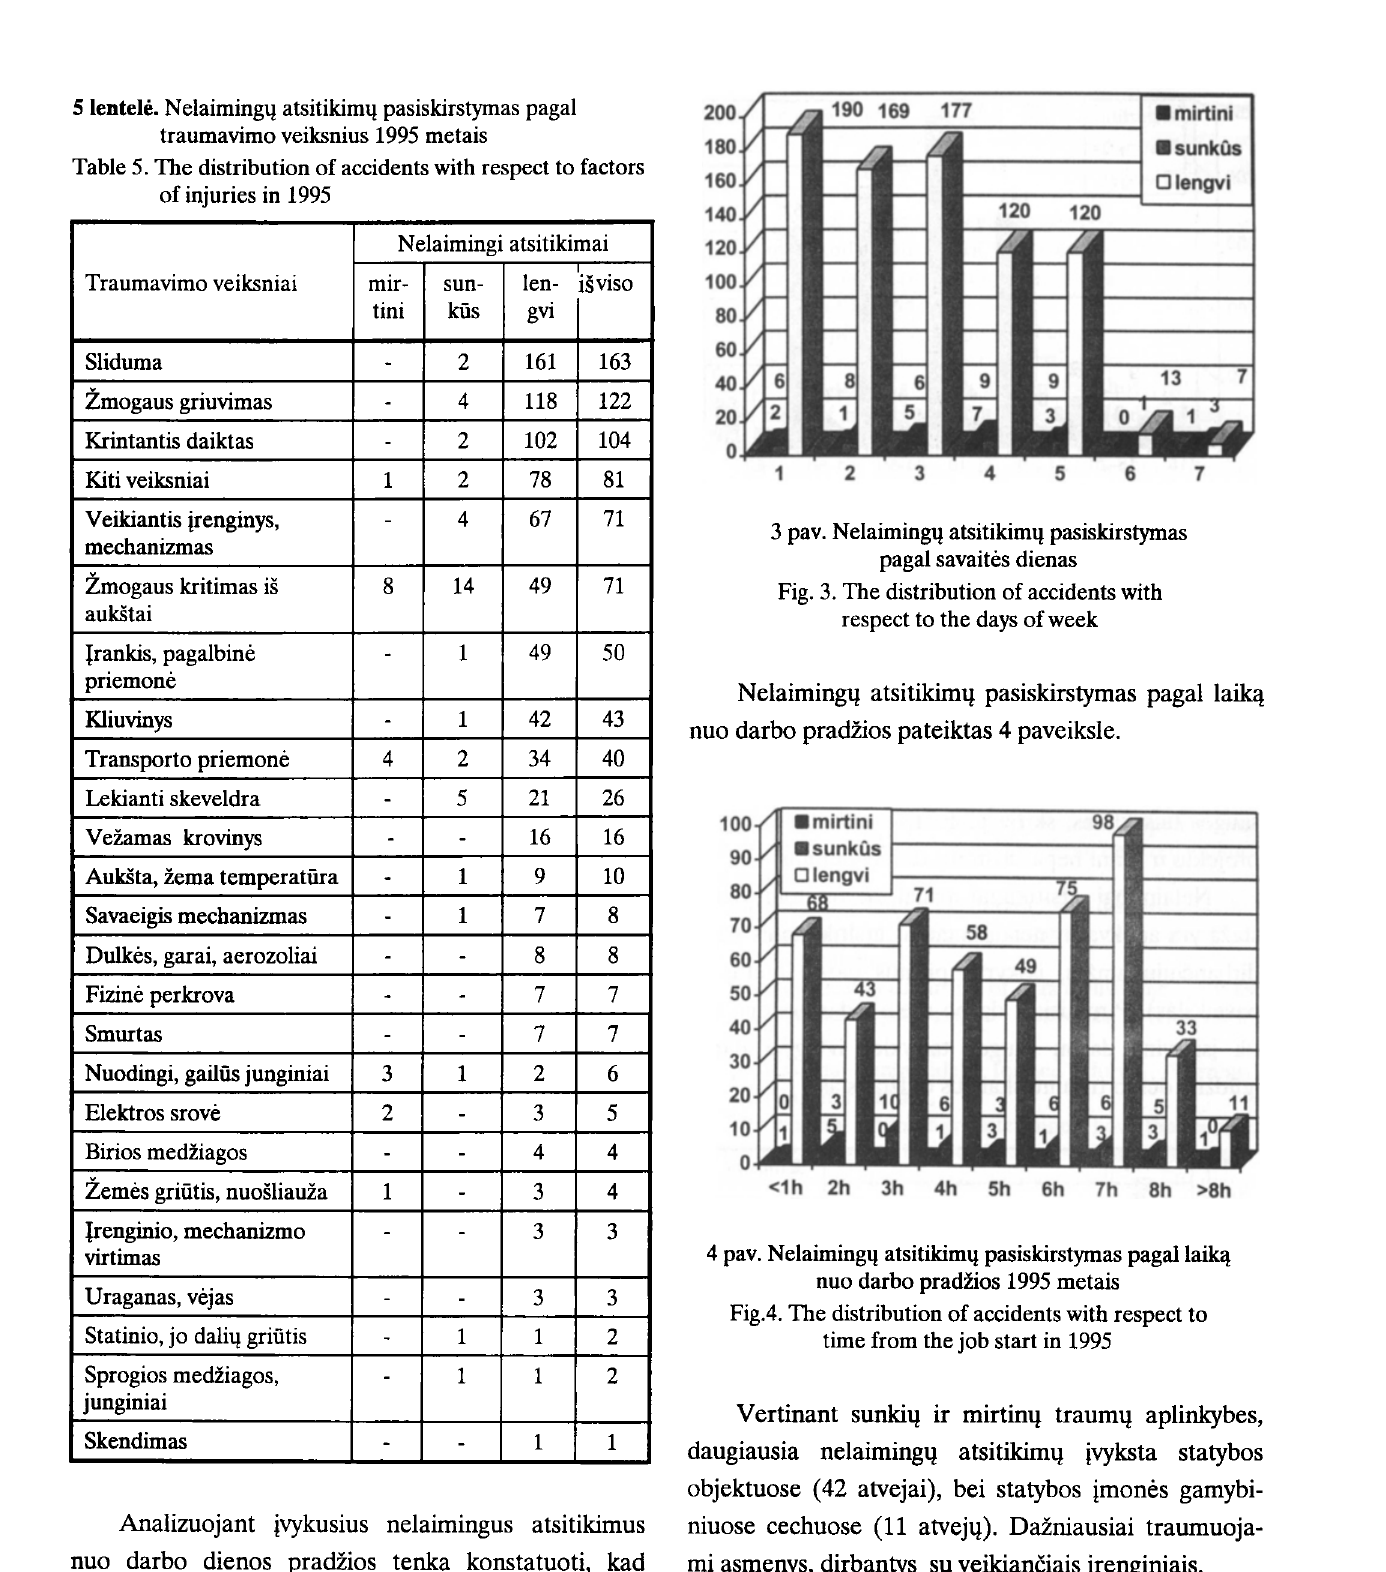
Table 5. The distribution of accidents with respect to factors of injuries in 1995 Nelaimingi atsitikimai